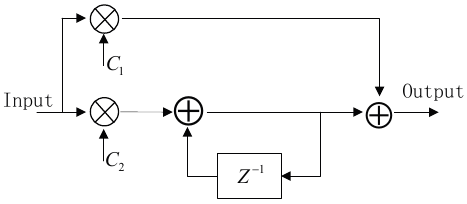
Figure 12. The frequency domain model of the second-order digital loop filter.